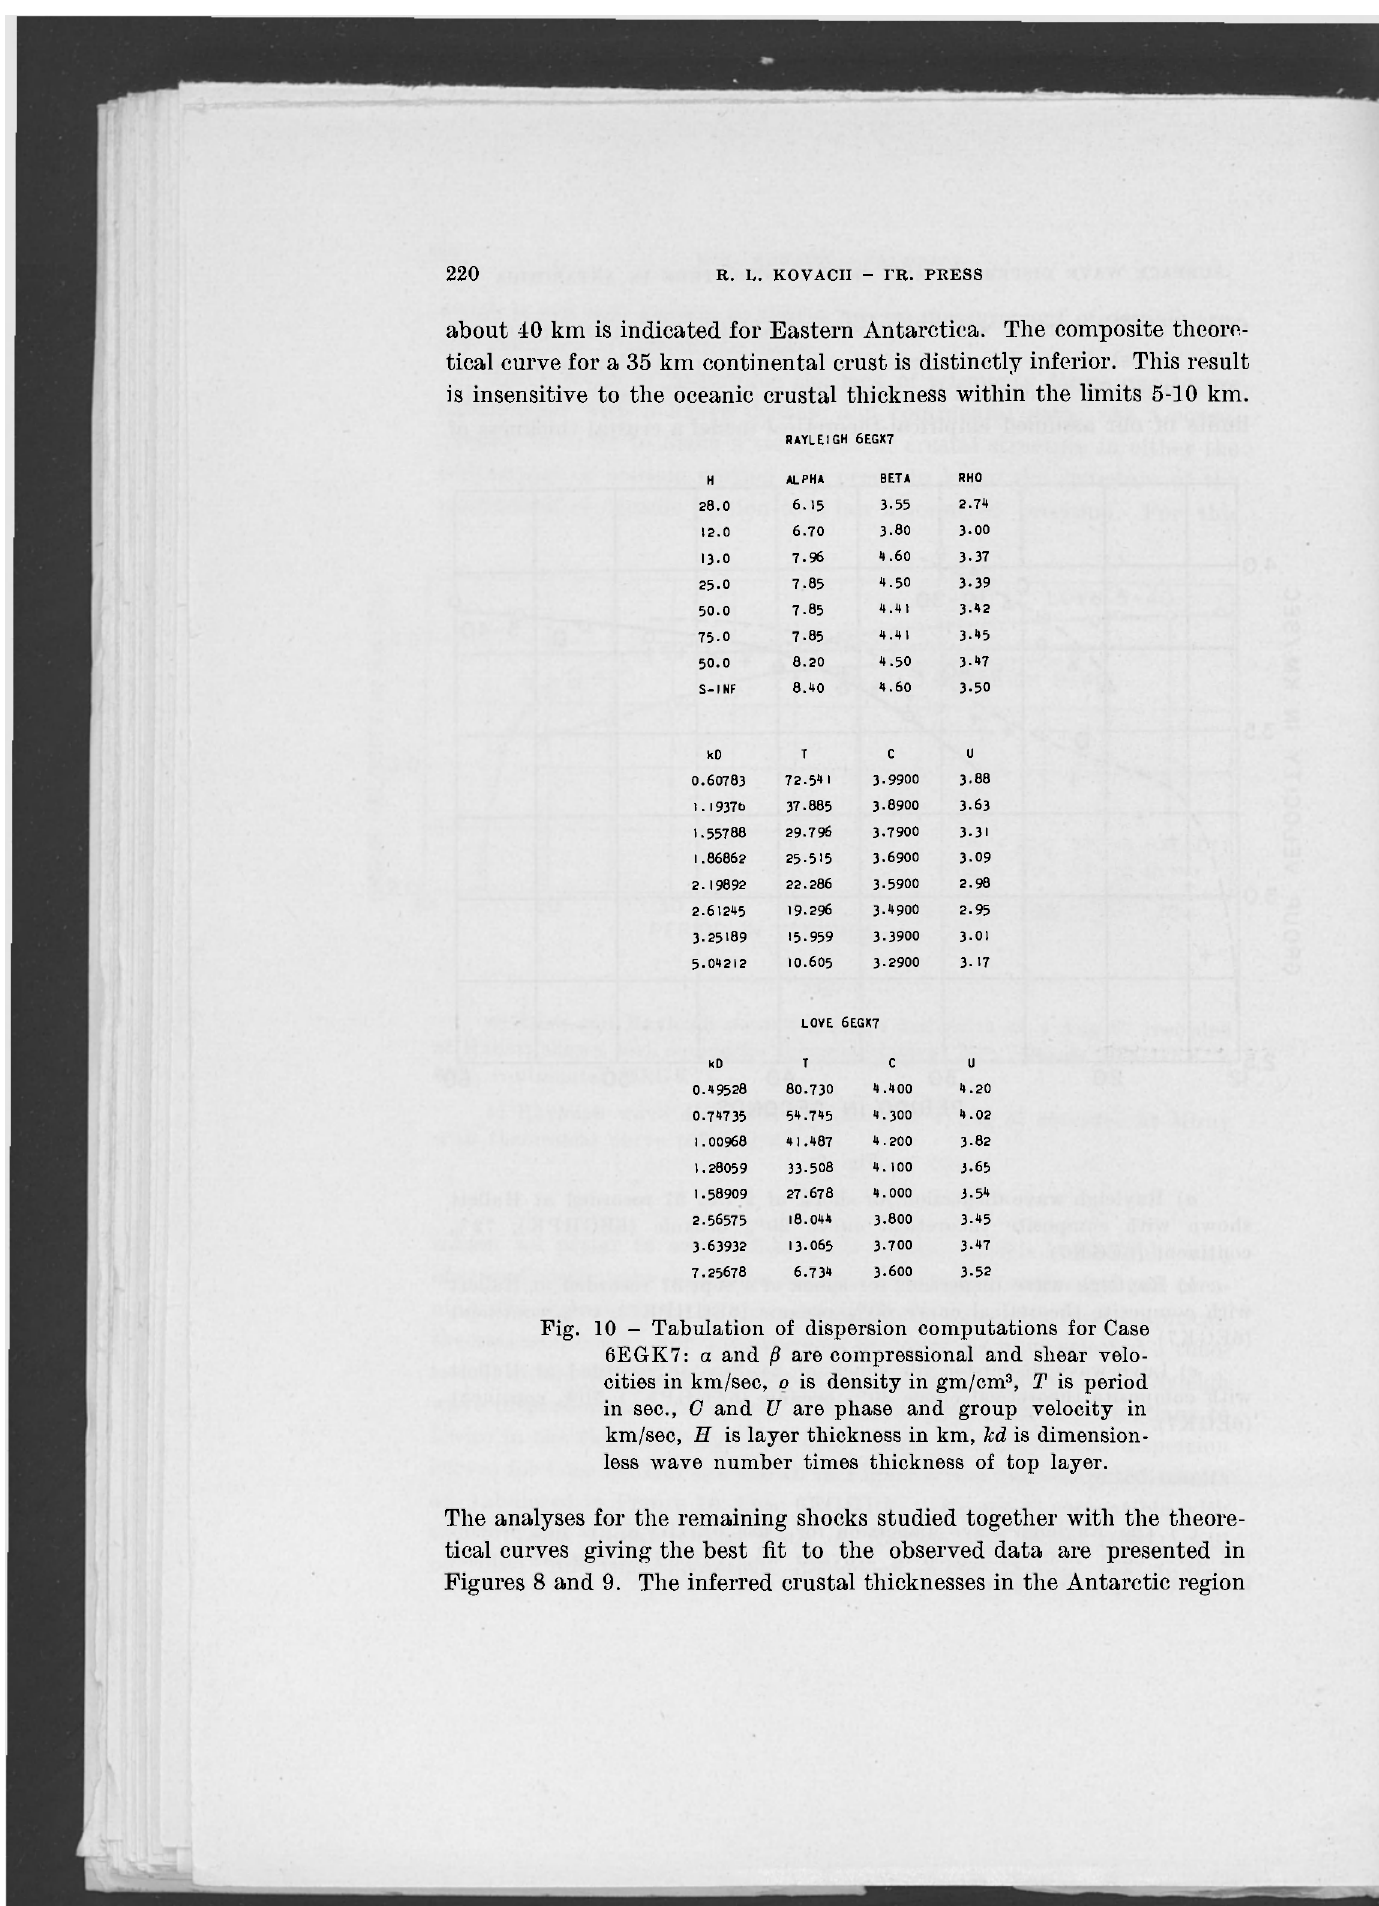
Fig. 10 - Tabulation of dispersion computations for Case 6EGK7: a and (3 are compressional and shear velo- cities in km/sec, o is density in gm/cm 3 , T is period in sec., C and U are phase and group velocity in km/sec, H is layer thickness in km, led is dimension- less wave number times thickness of top